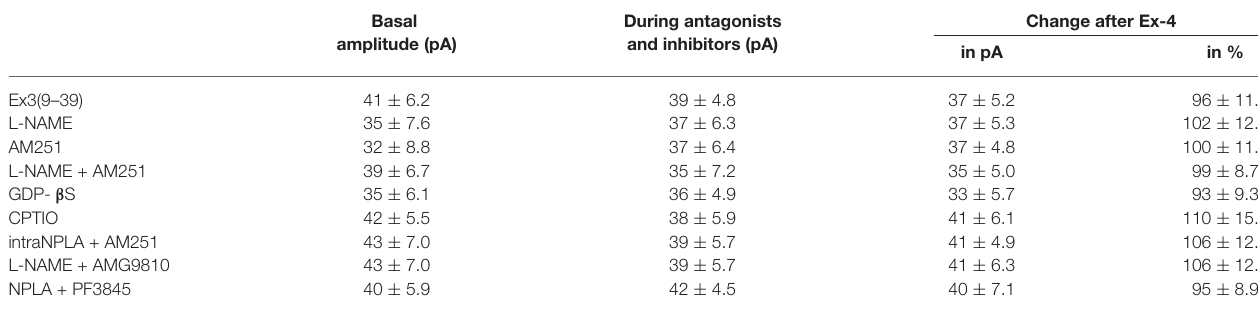
TABLE 6 | Changes in mPSC amplitude on GnRH neurons upon application of Exendin-4 after pretreatment with various antagonists or inhibitors. Basal During antagonists Change after Ex-4 amplitude (pA) and inhibitors (pA) in